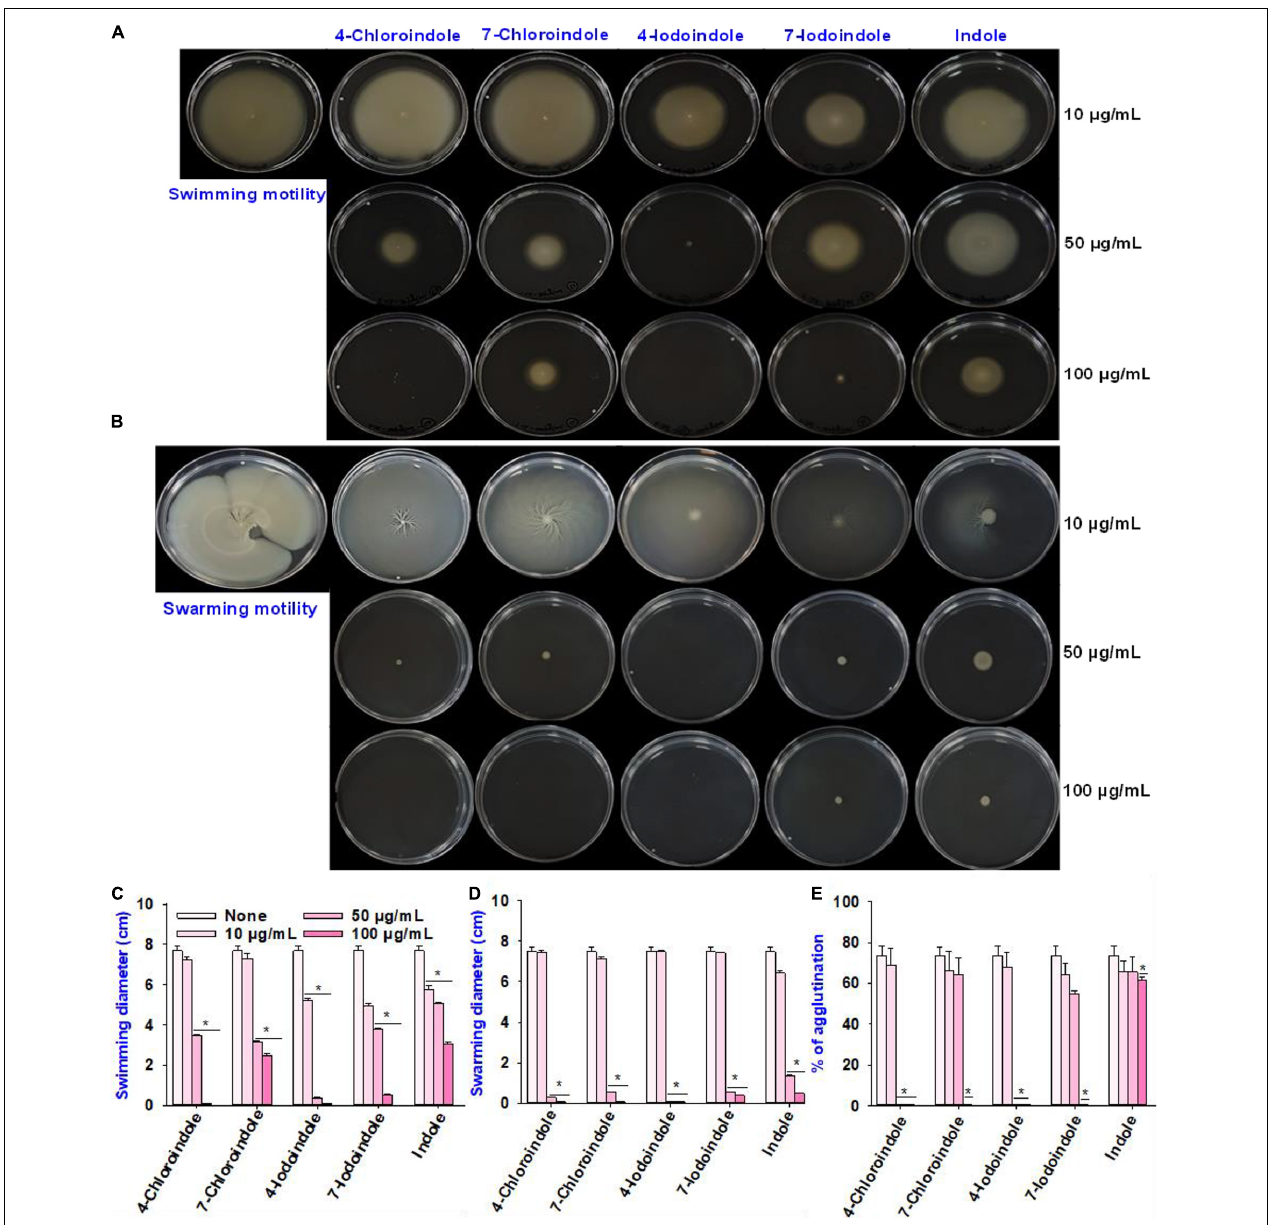
FIGURE 2 | Effects of halogenated indoles on the motility of V. parahaemolyticus. Swimming motility (A) , swarming motility (B) , measurement of migration in the swimming assay (C) , measurement of migration in the swarming assay (D) , and fimbria-mediated yeast agglutination (E) . Asterisks (*) represent significant differences ( p <